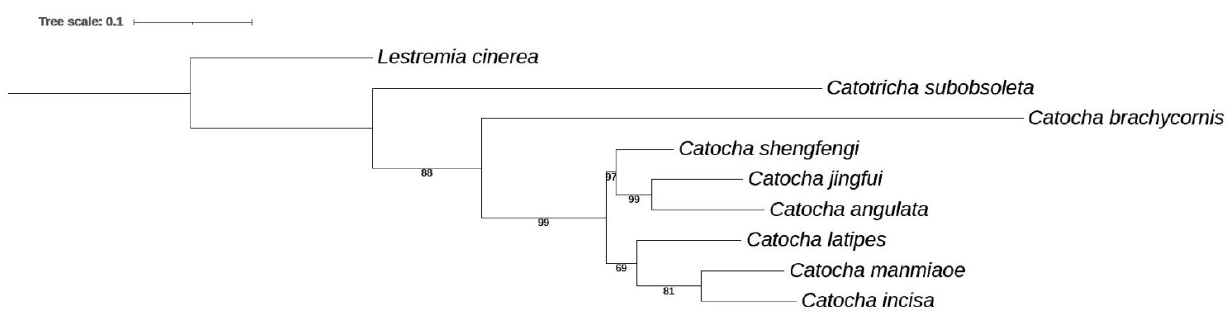
Figure 6. Phylogenetic relationships (Maximum Likelihood hypothesis) among the species Catocha based on two DNA markers (16S and COI).